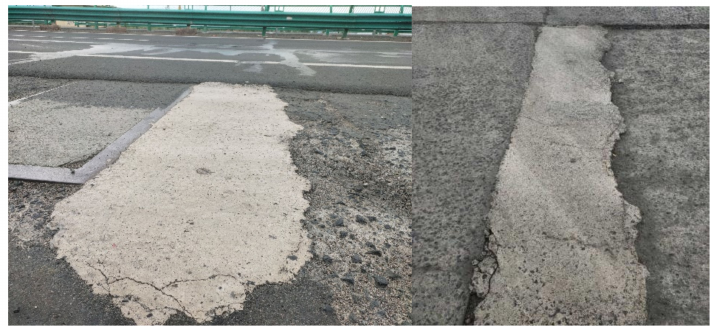
Figure 19. After nine months of service of the repaired